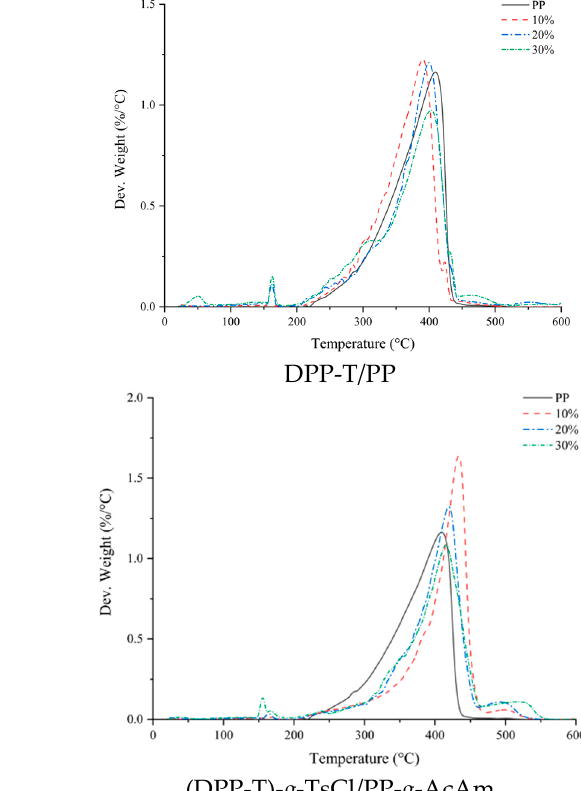
Figure 13. DTG curves of the developed bio-composites.